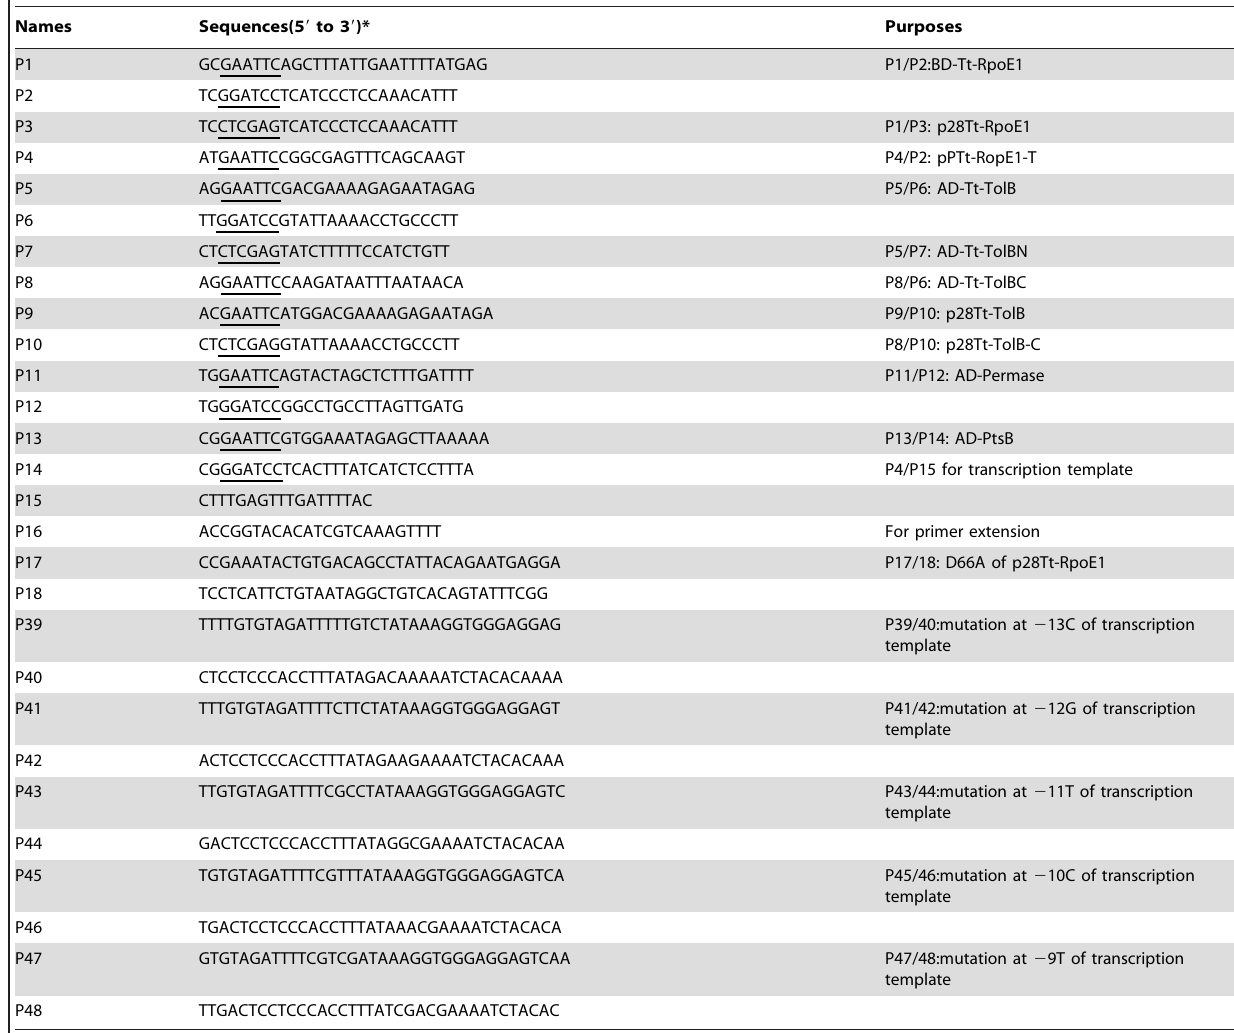
Table 2. Partial oligonucleotides used in this